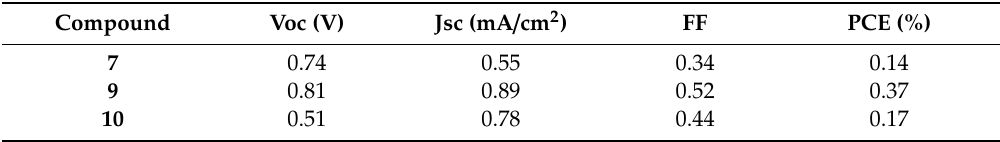
Table 2. The device data of organic photovoltaic cells (OPVs) based on 7 – 10 :PC 61 BM 1:1 under the illumination of a 150 W full spectrum solar simulator.